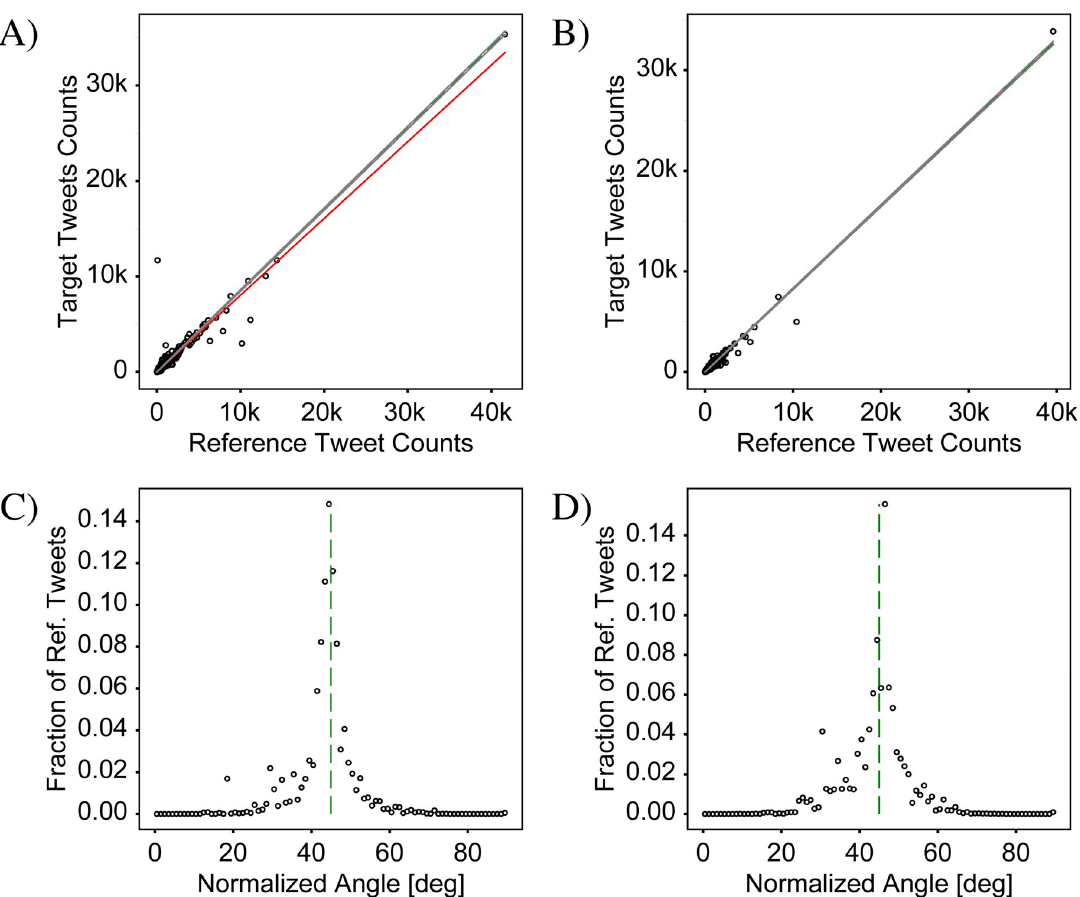
Fig 4. Correlation analysis for the data in Fig 3. (A) & (B) “Frequency comparison plots” in which target tweet counts are plotted against reference tweet counts for each bin for the CABA+ and CABA extents, respectively. Both plots show a high degree of correlation between target and reference tweet counts, indicating the lack of a driver of variation. A green-dashed line is used to represent the case of exact correlation, while the red line represents the best-fit line resulting from a regression analysis. Surrounding the exact-correlation line are two gray lines indicating the range of expected deviation resulting from random statistical variation when counting discrete elements (i.e., shot noise). (C) & (D) Plots of the normalized angle histograms corresponding to (A) and (B), respectively. The angle corresponds to the angle of a line drawn from the origin of the frequency comparison plot to an individual point after normalizing the counts by their respective sum. These histograms provide a complementary assessment of the degree of correlation between the target and reference tweet counts by showing how tightly the points are clustered around the exact-correlation line (again indicated by a green- dashed line). The two analyses differ in that the regression is more strongly affected by bins with high tweet counts while the histogram weighs all bins equally. The analysis here shows that counts of ‘v’ tweets and counts of ‘b’ tweets are highly correlated confirming lack of a driver of variation. CABA+ Statistics: N T = 560,334, N R = 657,233, S PCC = 0.04, KSS = 0.02, GMI = 0.01. CABA Statistics: N T = 325,514, N R = 394,175, S PCC = 0.01, KSS = 0.01, GMI =